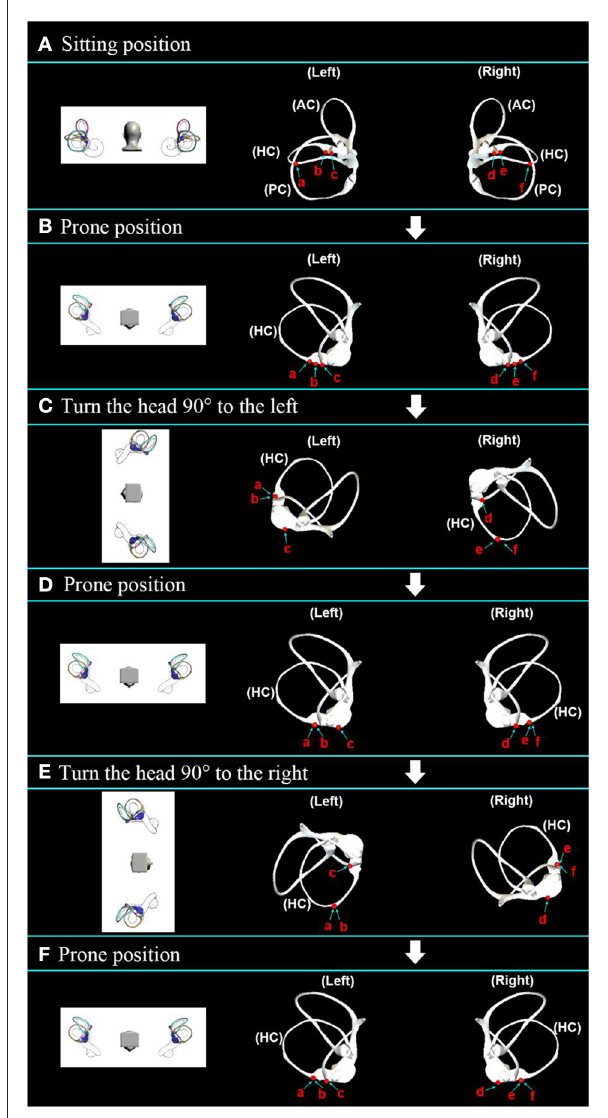
FIGURE7 Movement of the otoliths in the horizontal semicircular canal in the prone roll test. (A) Initial distribution setting of the otoliths in the sitting position. (B) The stable position of the otoliths after transfer from the sitting position to the prone position. (C) The stable position of the otoliths after further rotation to the left by 90 ◦ . (D) The stable position of the otoliths after returning to the prone position. (E) The stable position of the otoliths after a further 90 ◦ rotation to the right. (F) The stable position of the otoliths